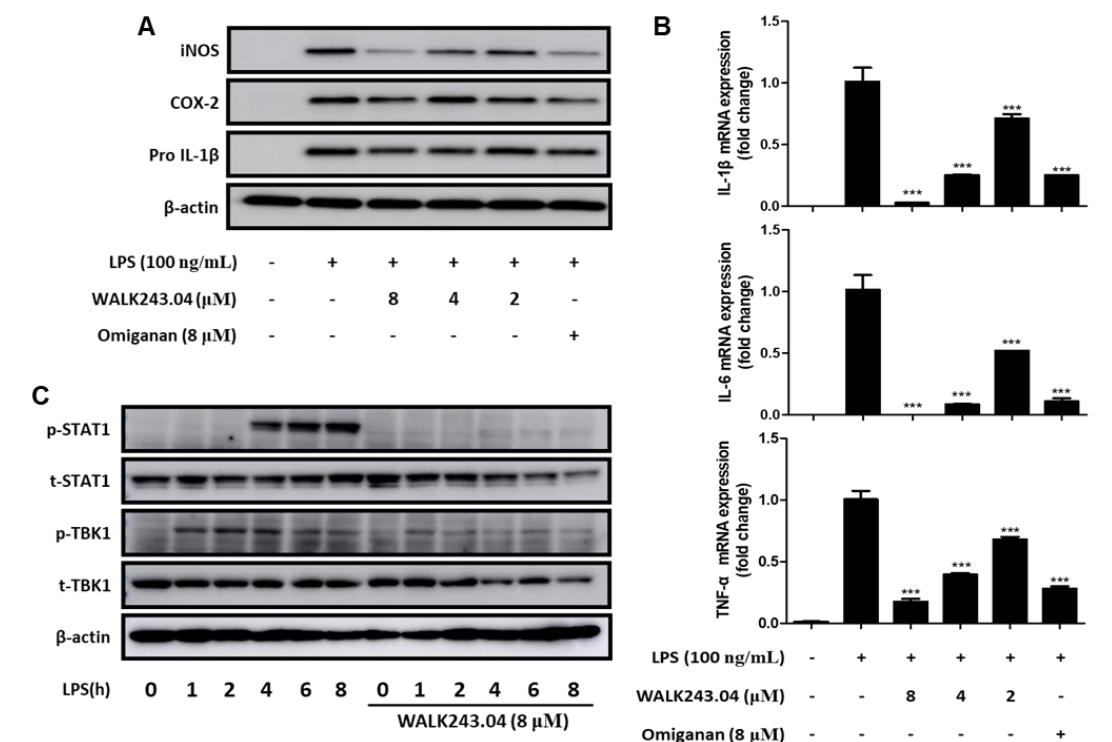
Figure 6. Anti-inflammatory effects of WALK243.04 peptide in Raw264.7 cells. The cells were pretreated with the peptide at indicated concentrations for 5 min, followed by stimulation with LPS (100 ng/mL) to induce inflammatory responses. ( A ) iNOS, COX-2, and pro-IL-1 β expression levels were estimated by Western blot analysis after 16 h of LPS treatment. ( B ) The mRNA expression of IL-1 β , IL-6, and TNF- α was determined by quantitative real-time PCR after 3 h of stimulation with LPS. All bar graphs represent the mean ± SEM of three independent experiments (*** p < 0.001, significantly different from the control group treated with LPS alone). ( C ) The phosphorylation of STAT1 and TBK1 was analyzed by Western blot analysis at different time points after LPS treatment.